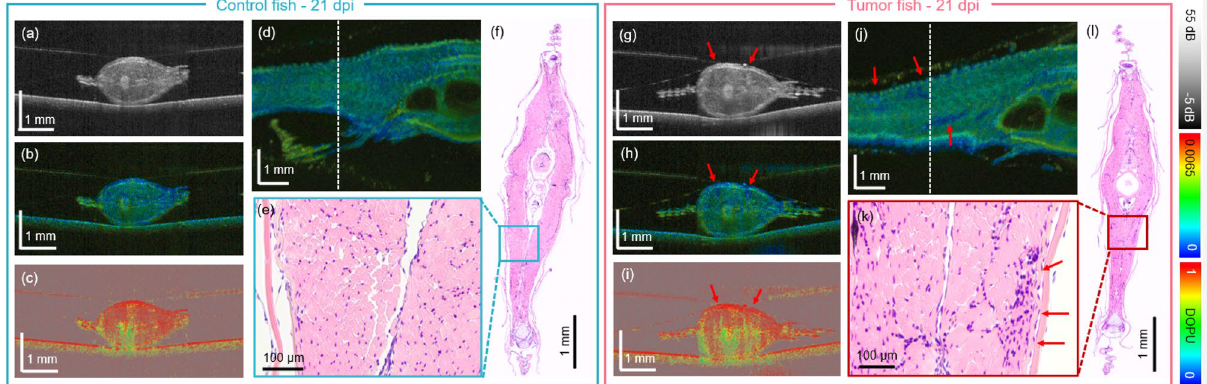
Figure 2. The JM-OCT in comparison to the histology results for the second generation of xenograft zebrafish at 21 days post-injection (dpi). ( a – d ) Scatter intensity, birefringence, DOPU transverse cross-sections and birefringence en-face image in a PBS injected control model. ( e – f ) H &E-stained histology micrographs in transverse direction and zoom-in image in the control animal. ( g – j ) Scatter intensity, birefringence, DOPU transverse cross-sections and birefringence en-face image in a tumor injected fish. ( k – l ) H &E-stained histology micrographs in transverse direction and zoom-in image in the tumor-bearing animal. The tumor location is indicated by red arrows. The locations of the transverse sections are indicated by white dashed lines in the en-face images.